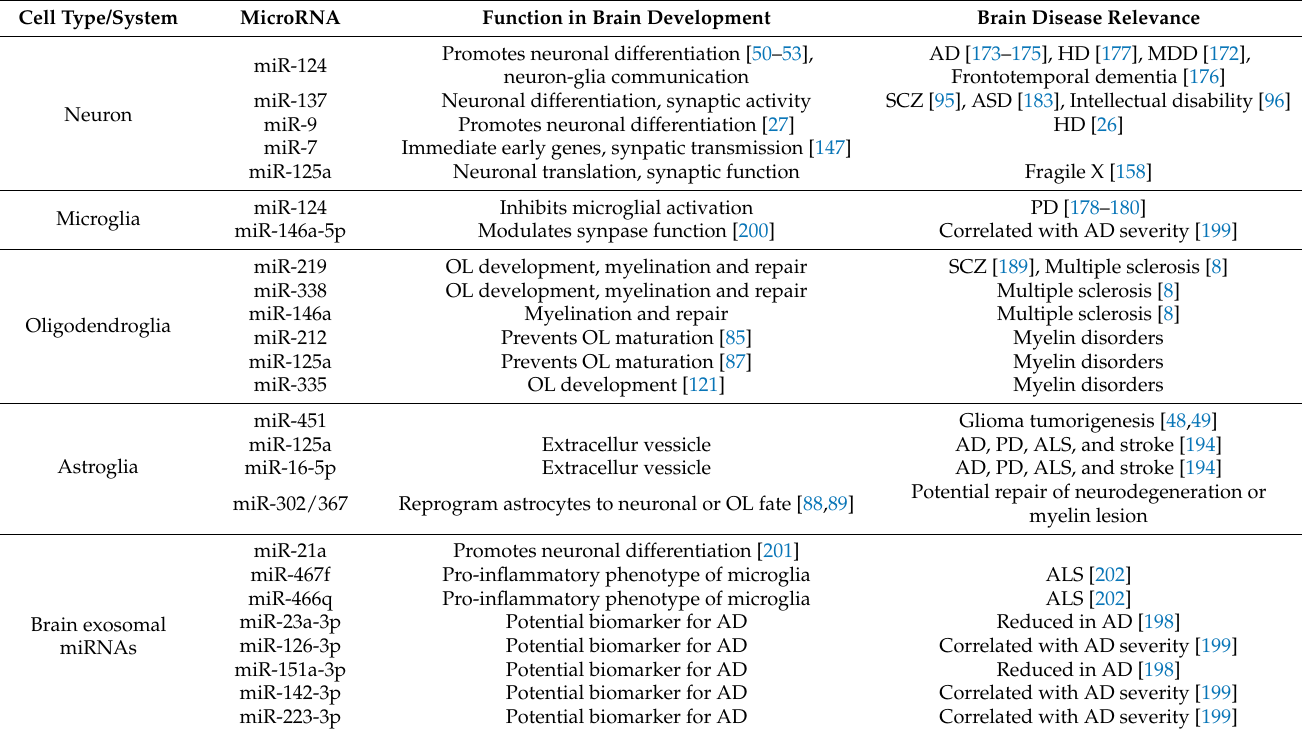
Table 1. Neuronal and glial miRNAs in brain disease. References in the table correspond to references in the body of the text of this review